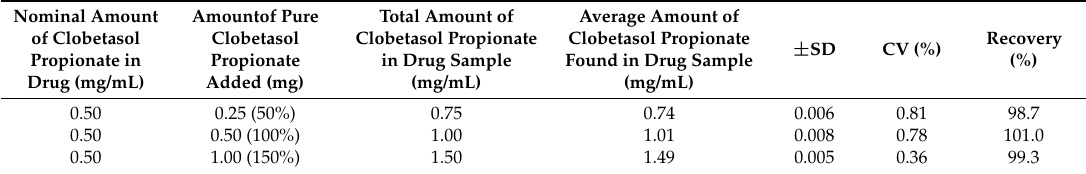
Table 3. Results of